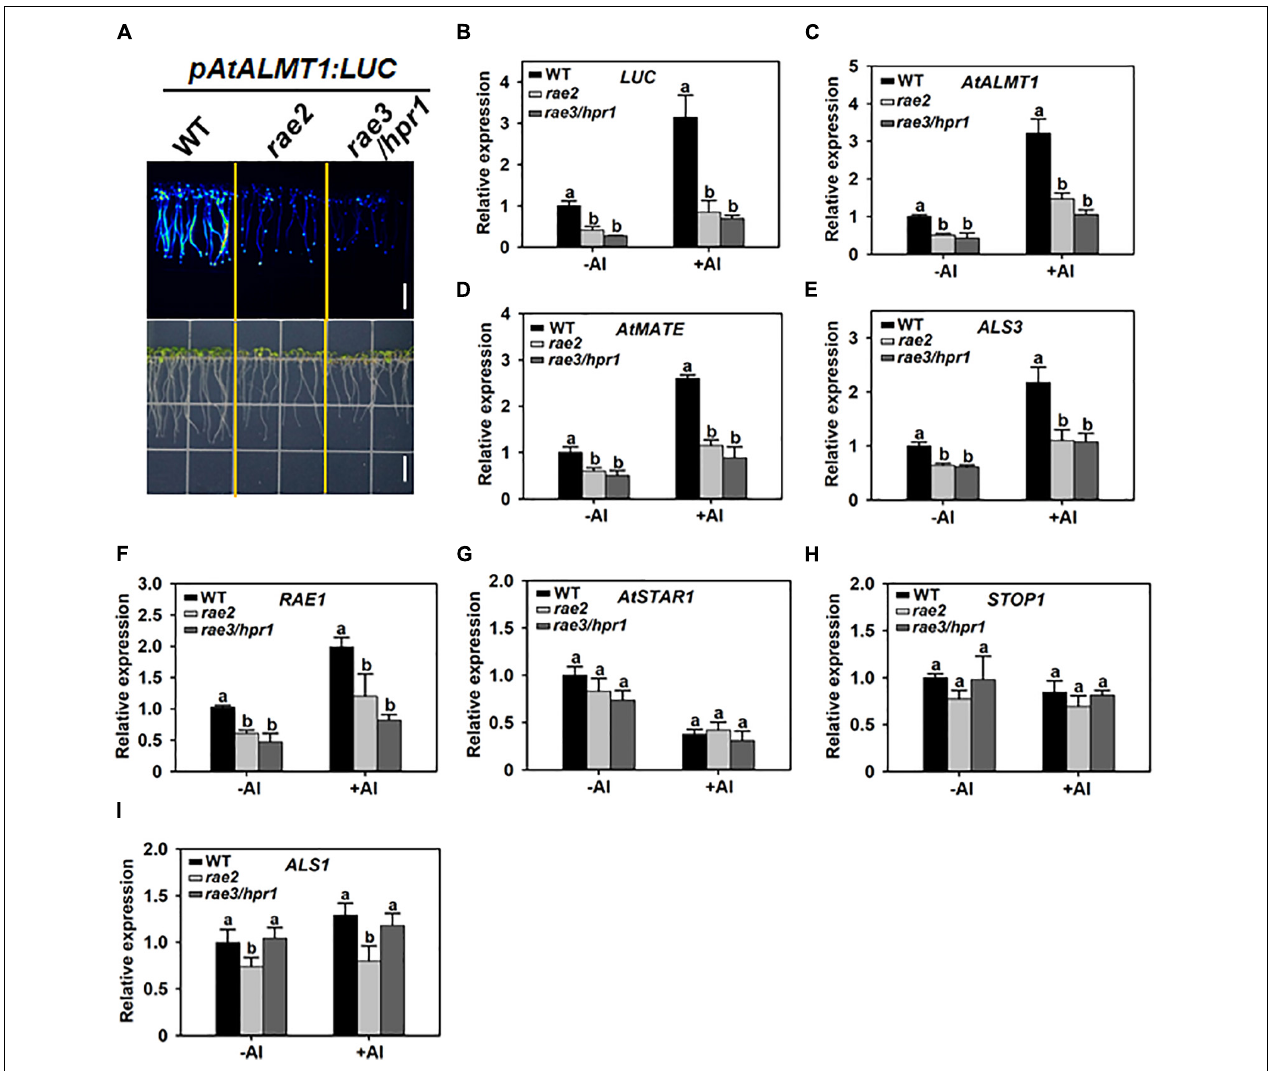
FIGURE 1 | Mutation of RAE2 decreases the expression of STOP1-regulated genes. (A) Decreased LUC signal of pAtALMT1:LUC in rae2 mutant compared with wild type (WT). Bar = 7 mm. (B–F) Reduced mRNA expression of STOP1-regulated genes in rae2 and rae3 / hpr1 , which include LUC reporter gene (B) , AtALMT1 (C) , AtMATE (D) , ALS3 (E) , and RAE1 (F) . (G–I) Comparison of the expression levels of non-STOP1-target genes in WT, rae2, and rae3 , which include AtSTAR1 (G) , STOP1 (H), and ALS1 (I) . Seven-day-old seedlings were exposed to 0 (–Al) or 30 µ M Al (+Al) for 12 h, and then the roots were excised for the expression analysis. Data shown are means ± SD of three biological replicates. Different letters at each treatment indicate the values significantly different ( P < 0.05, ANOVA followed by Tukey’s